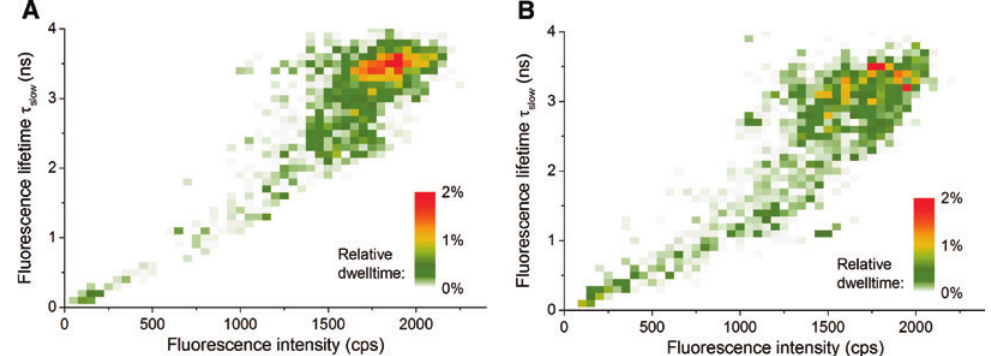
Figure 4: Comparison of the fluorescence lifetime of about 150 LHCII trimers in detergent (A) and in the lipid environment of SMA nanodisks (B). The color code represents the overall dwell-time probability of complexes within an intensity bin of 50 cps and a lifetime bin of 100 ps. The two graphs depict the fluorescence lifetime without the contribution of S-T annihilation, while the measured fluorescence intensity is satu- rating slightly at larger lifetime values due to the effect of annihilation. Reproduced from Ref. [32]. Copyright (2016) Society of Photo Optical Instrumentation